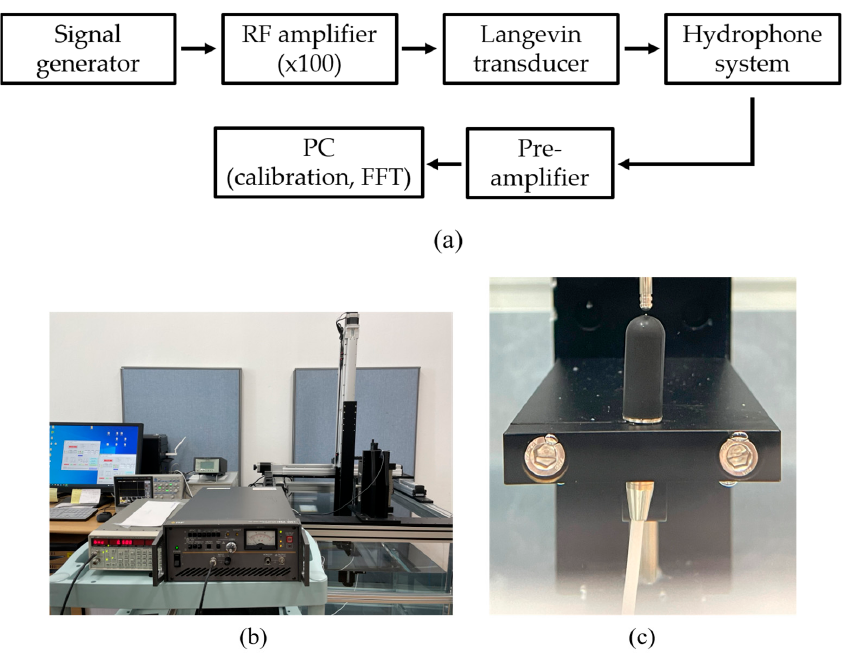
Figure 2. Pressure calibration system: ( a ) flow chart of measurement procedure, ( b ) complete system, ( c ) enlarged view of the transducer with a round tip and hydrophone in the water tank.